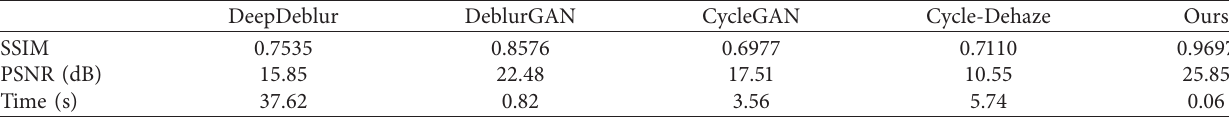
Table 5: Comparison of quantitative deblurring performance on LTIR datasets.